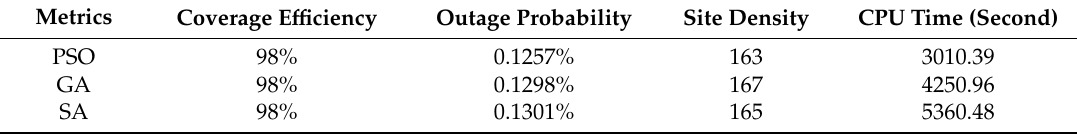
Table 5. Metrics comparison (PSO vs. genetic algorithm (GA) vs. SA) for 2000